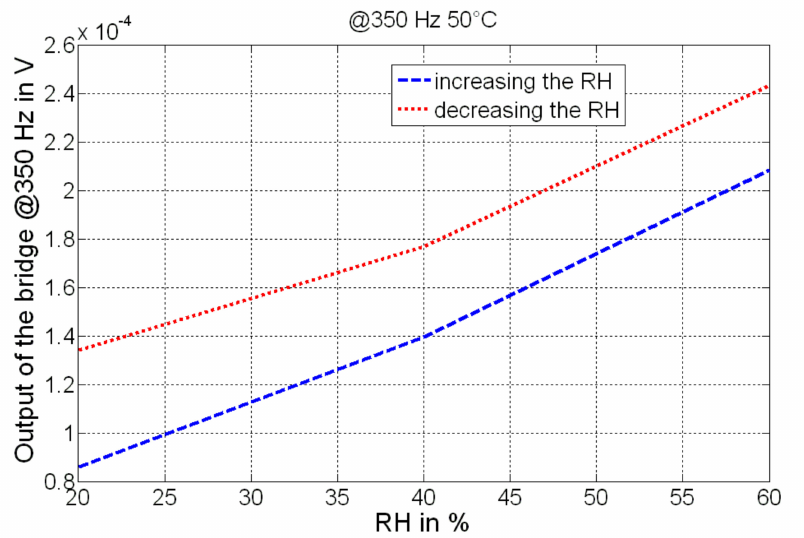
Figure 10. Output of the conditioning circuit used for the MEMS, considering the increasing and the decreasing condition of RH. The analysis has been conducted at a fixed sinusoidal excitation (evaluated at 350 Hz) and at a fixed temperature (50 ◦ C).